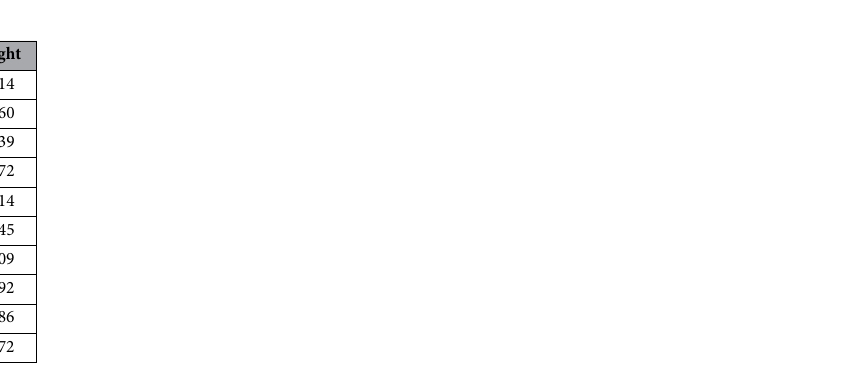
Table 8. Feature weights calculated by information gain applied on 2-classes-dataset of GOS0. GCSM0: motor component of GCS on admission, INR: international normalized ratio, DC: decompressive craniotomy, BS: blood sugar, SAH: subarachnoid